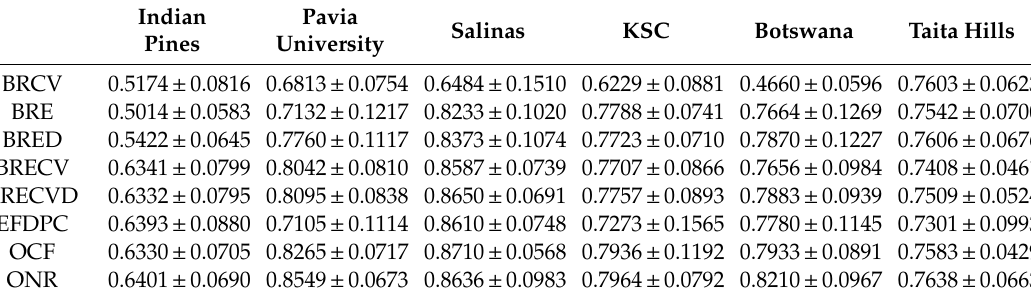
Table 3. OAs by KNN with standard deviation averaged over 30 selected